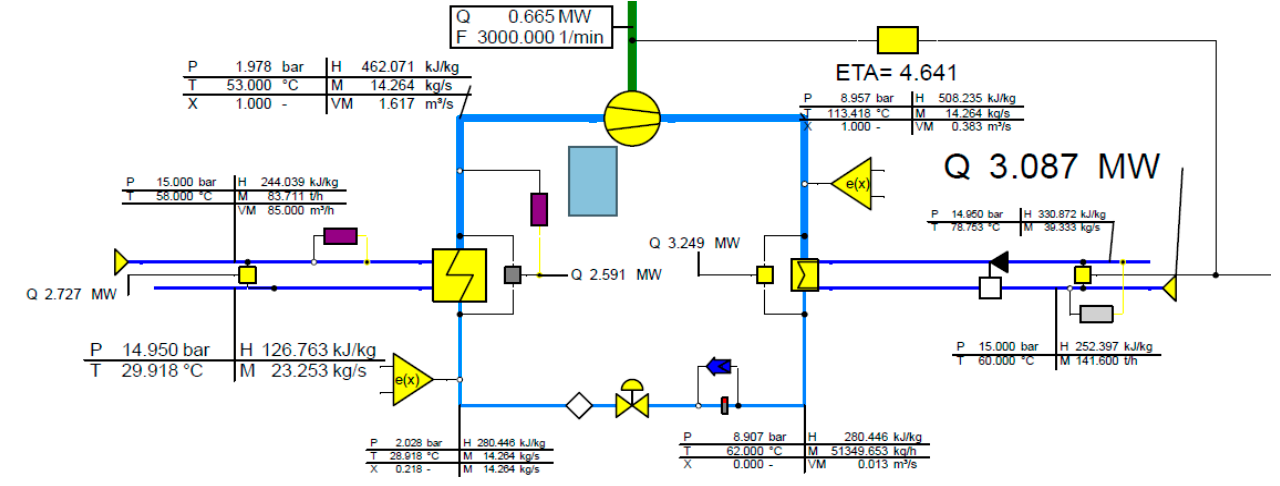
Figure 10. View of the Ebsilon professional window—basic variant.